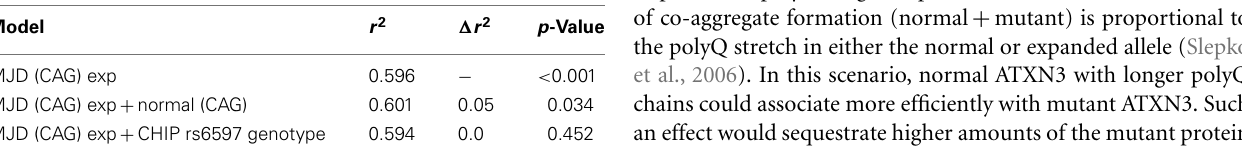
Table 3 | Multiple linear regression analyses of possible candidate genetic modifiers of log-transformed age at onset in Machado–Joseph disease.